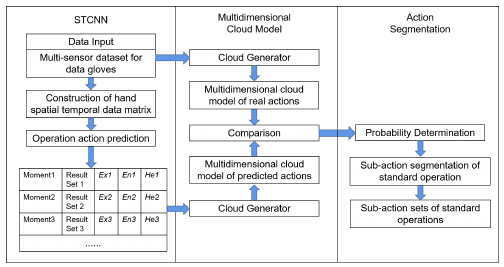
Figure 2. Joint-algorithm-refined flow